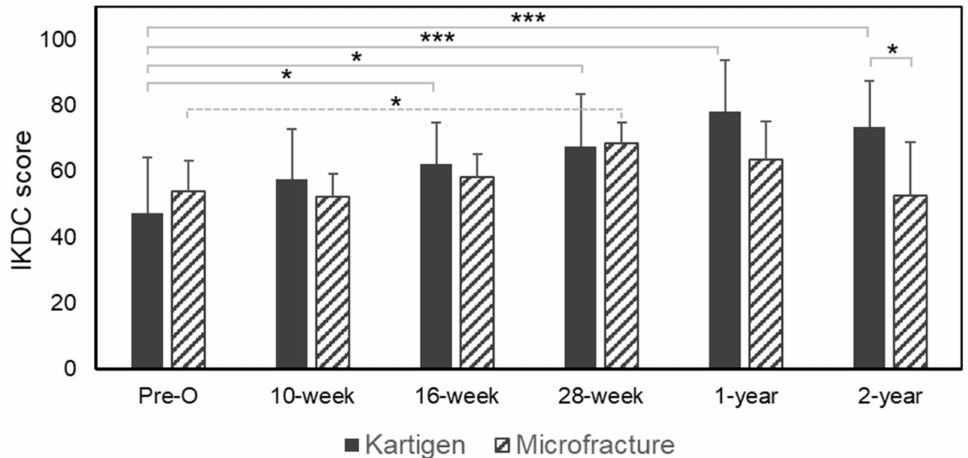
Figure 1. Assessment of knee functions of daily activities by IKDC scores. The knee functions of the patients were significantly improved 16 weeks after the Kartigen ® implantation and 28 weeks after microfracture, respectively. The paired t -test was conducted to determine the difference between the means of the IKDC scores before and after the treatments at different time points among the same groups. Two years after operation, the IKDC score of the Kartigen ® group was higher than the control group. The error bars stand for standard deviations. Asterisks represent the statistical significance: * p < 0.05, *** p < 0.005.